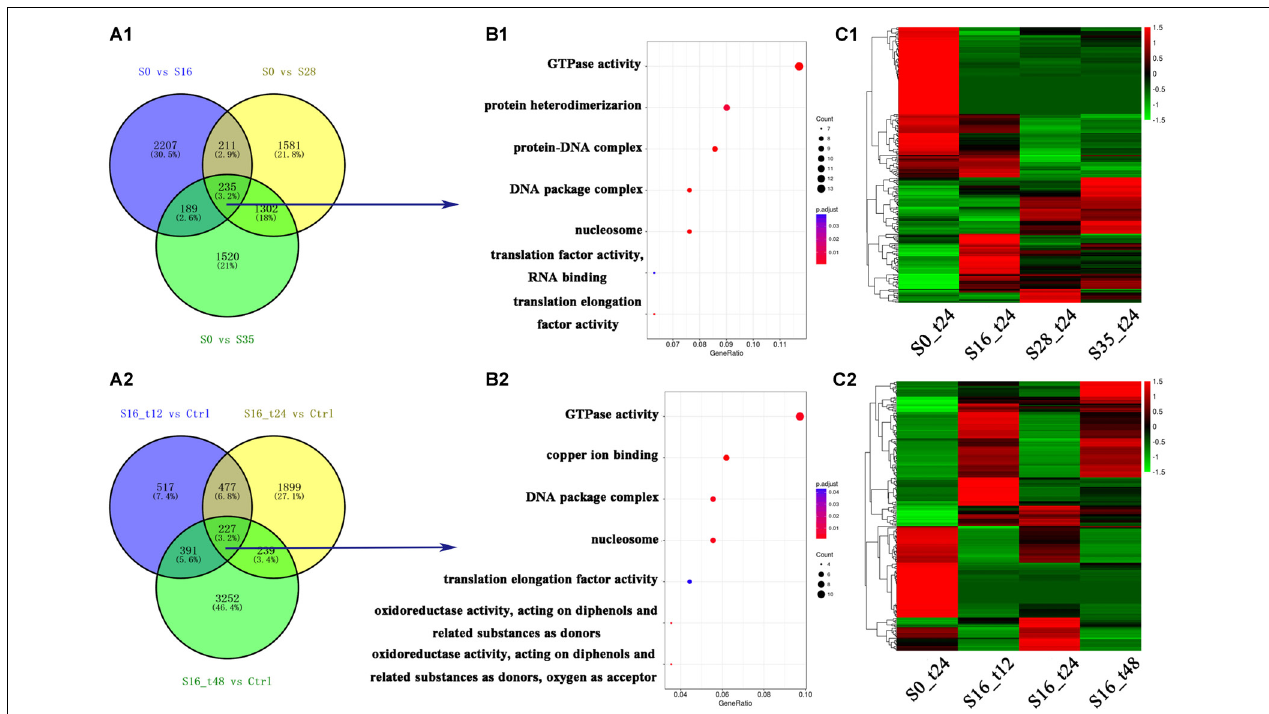
FIGURE 1 | Grouping and enrichment analysis of differentially expressed genes. (A1) Grouping of the differentially expressed genes in S16_t24, S28_t24, and S35_t24 groups. (A2) Grouping of the differentially expressed genes in S16_t12, S16_t24, and S16_t48 groups. (B1) Enrichment analysis of the 235 differentially expressed genes shared by the gene lists in S16_t24, S28_t24, and S35_t24 groups. (B2) Enrichment analysis of the 277 differentially expressed genes shared by the gene lists in S16_t12, S16_t24, and S16_t48 groups. (C1) Cluster map of the differentially expressed genes in the S16_t24, S28_t24, and S35_t24 groups. (C2) Cluster map of the differentially expressed genes in the S16_t12, S16_t24, and S16_t48 groups.